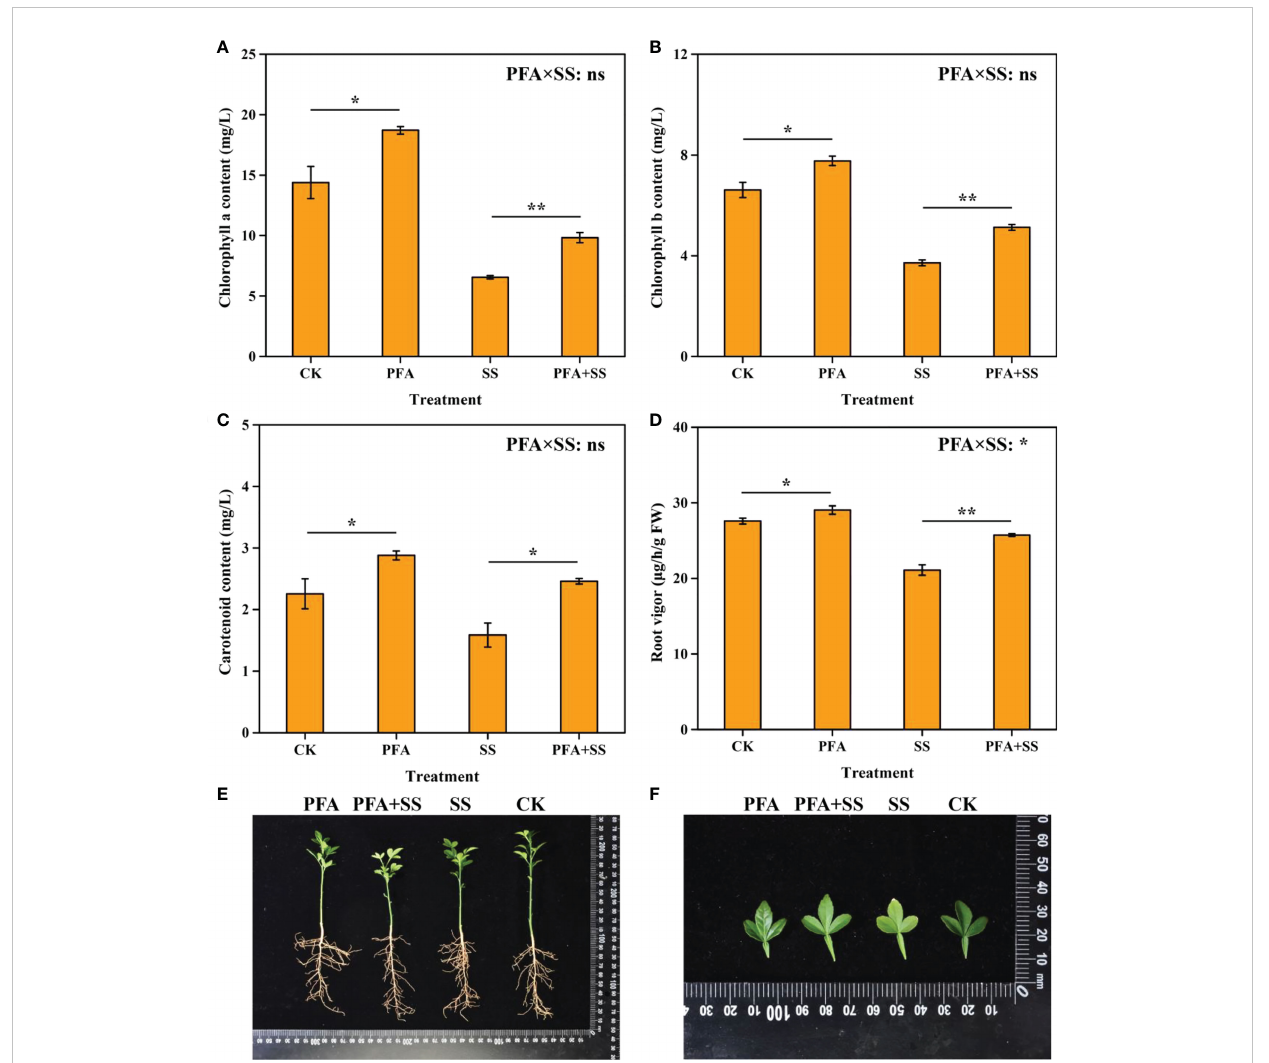
FIGURE 1 The contents of chlorophyll a (A) , chlorophyll b (B) , carotenoid (C) and root vigor (D) , plant growth (E) , leaves (F) of the seedlings. CK, the seedlings without PFA and salt stress; PFA, the seedlings amended with PFA and without salt stress; SS, the seedlings with salt stress; PFA+SS, the seedlings amended with both PFA and salt stress. PFA × SS, interaction between PFA and SS. The error bars represent the standard error (n = 3). “ ns ” , “ * ” , and “ ** ” mean not signi fi cant, p < 0.05 and p < 0.01 according to Student ’ s t test and two-way ANOVA,